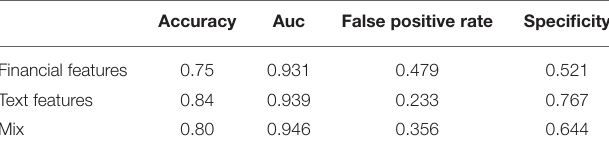
TABLE 6 | Results from Lasso logistic regression.